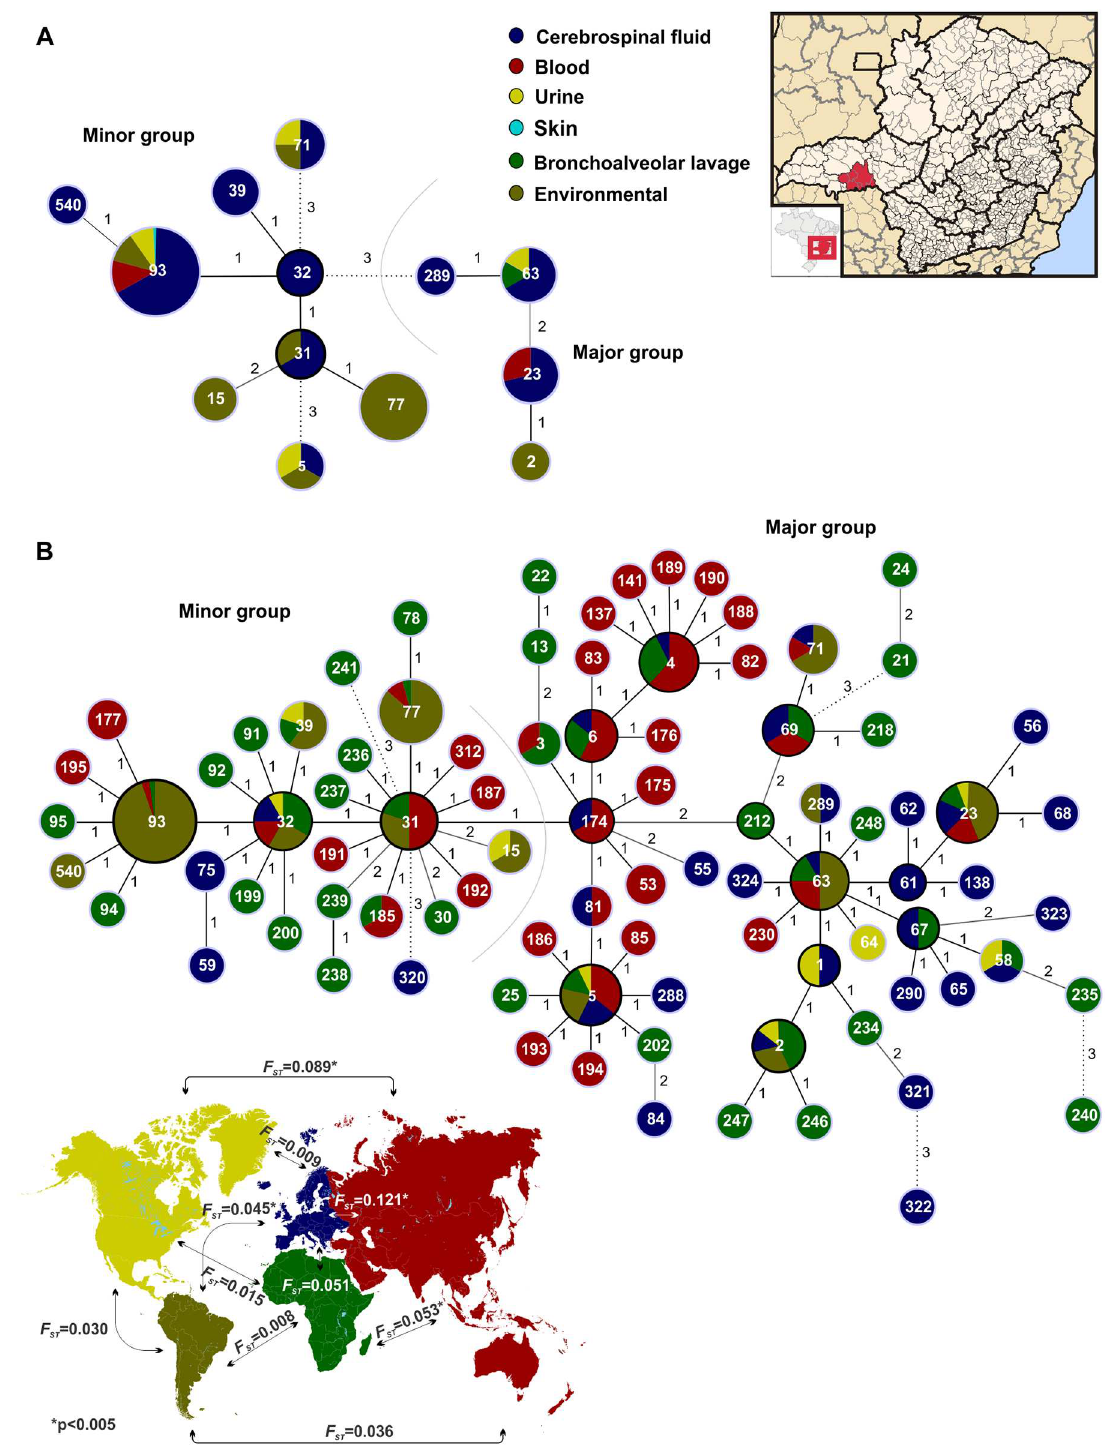
Fig 3. A) Minimum spanning tree showing the distribution of the 143 Cryptococcus neoformans var. grubii VNI isolates from southeastern Brazil according to the source of isolation . Two main clusters were identified.The first composed of the clonal complexes (CC) CC31 and CC32, which are both linked with the most frequent STs found in the study, ST93 (recovered from both clinical and environmental samples) and ST77 (recoveredonly from environmental samples). The second main cluster is representedby the ST289, ST63, ST23, and ST2. Each circle representsa uniqueST, and